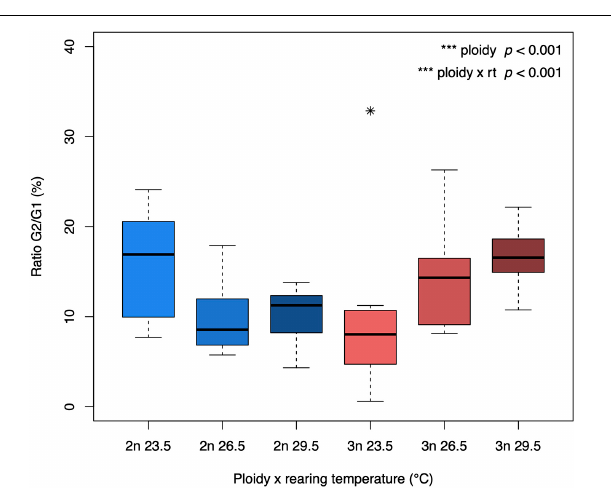
FIGURE 2 | G2/G1 ratio of diploid and triploid larvae reared at different temperatures. The ratio of cells in the G1 and G2 phase was calculated as G2/G1*100 for each larva. The box extends from the lower quartile to the upper quartile of the data, spanning the inter-quartile range (IQR). The thick line within the box represents the median. Whiskers extend to minima and maxima, but are limited to data points 1.5 times outside the IQR. The asterisk represents an outlier. The effect of ploidy and the interaction between ploidy level and rearing temperature were significant (ANOVA, p < 0.001, n =